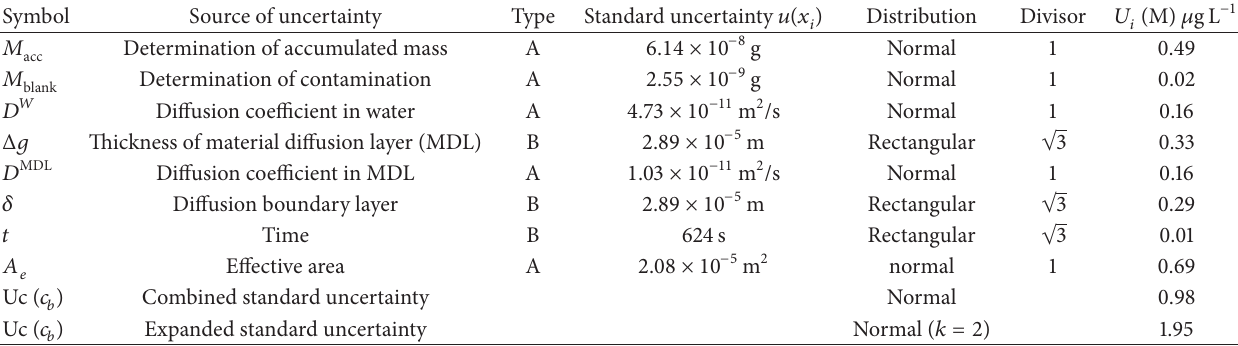
Table 5: Uncertainty budget for determination of time weighted average concentration of Cu 2+ in water using a DGT passive sampler.